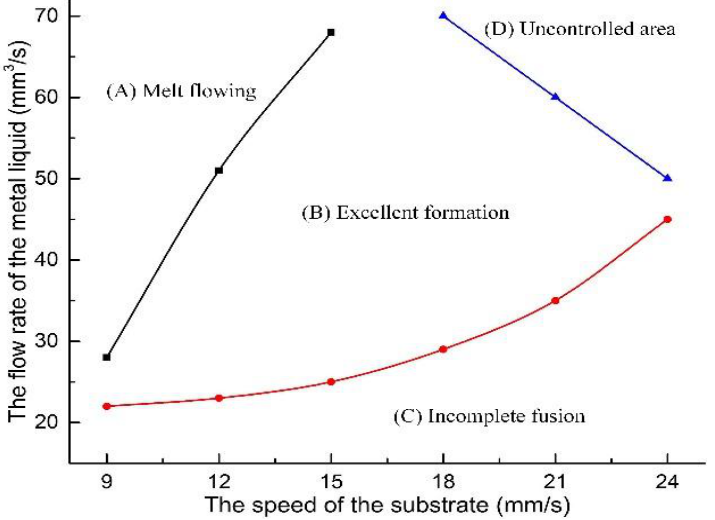
Figure 2. Process parameter set of various forming morphology in a single-layer single pass (SLSP).